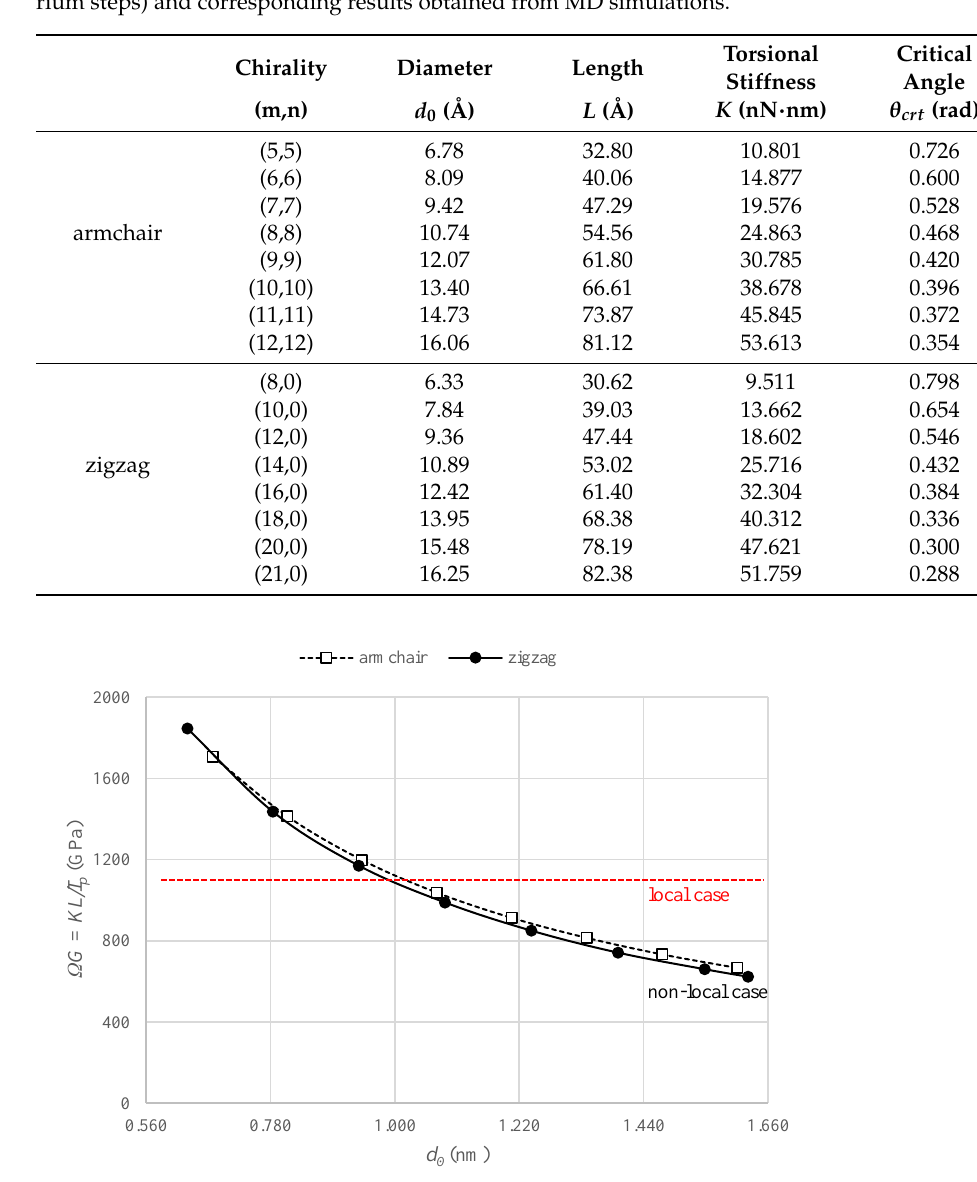
Table 1. Parameters of carbon nanotubes (measured after energy minimization and thermal equilib- rium steps) and corresponding results obtained from MD simulations.